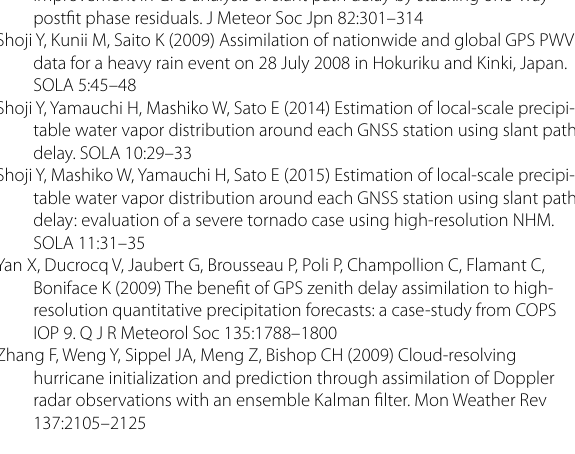
table water vapor distribution around each GNSS station using slant path delay. SOLA